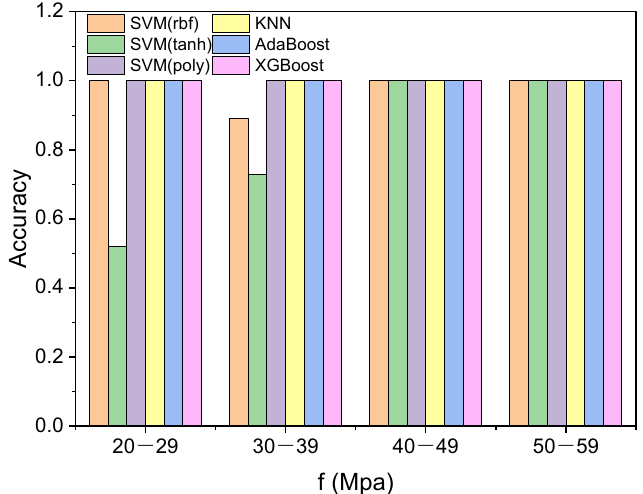
Figure 9. The accuracy of models in terms of the compressive strength of concrete.